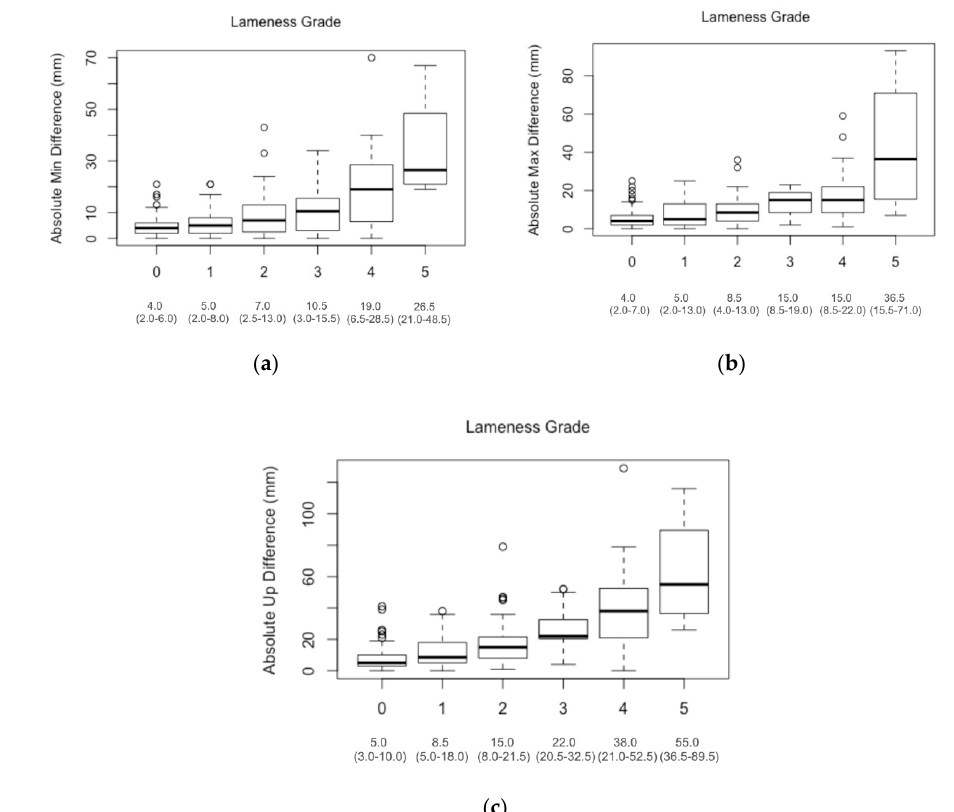
Figure 2. Box plots illustrating the distribution of three pelvic asymmetry measures for visual lameness grades 0 to 5 in n = 301 horses assessed by one board-certified specialist at a veterinary hospital in Switzerland. For each grade the asymmetry measures are summarised in the box plot as median (interquartile range) in mm: ( a ) AbPDMin, ( b ) AbPDMax and ( c ) AbPDUp.